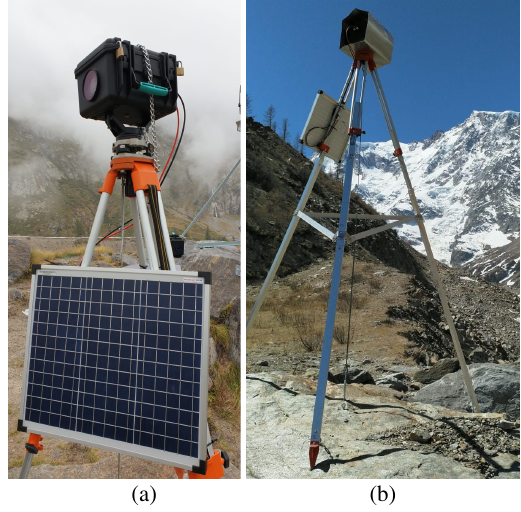
Figure 5. (a) Picture of the monitoring unit prototype installed for tests at the Belvedere Glacier site. (b) Picture of the final monumentation of the camera installed on the stream-wise right moraine.